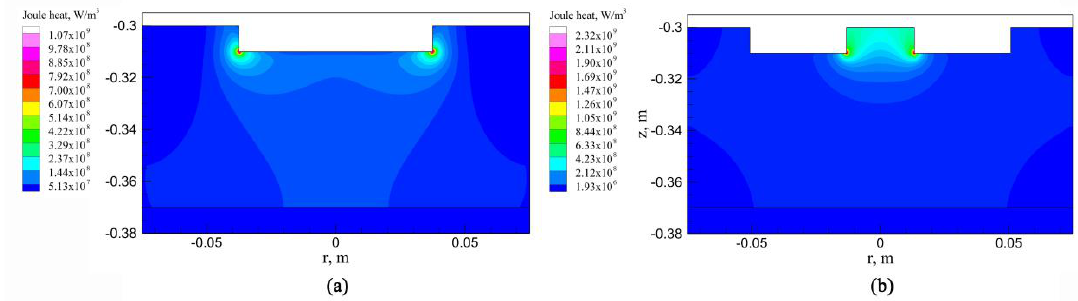
Figure 7. Joule heat distribution in slag pool. ( a ) OE-ESR. ( b ) TSCE-ESR.